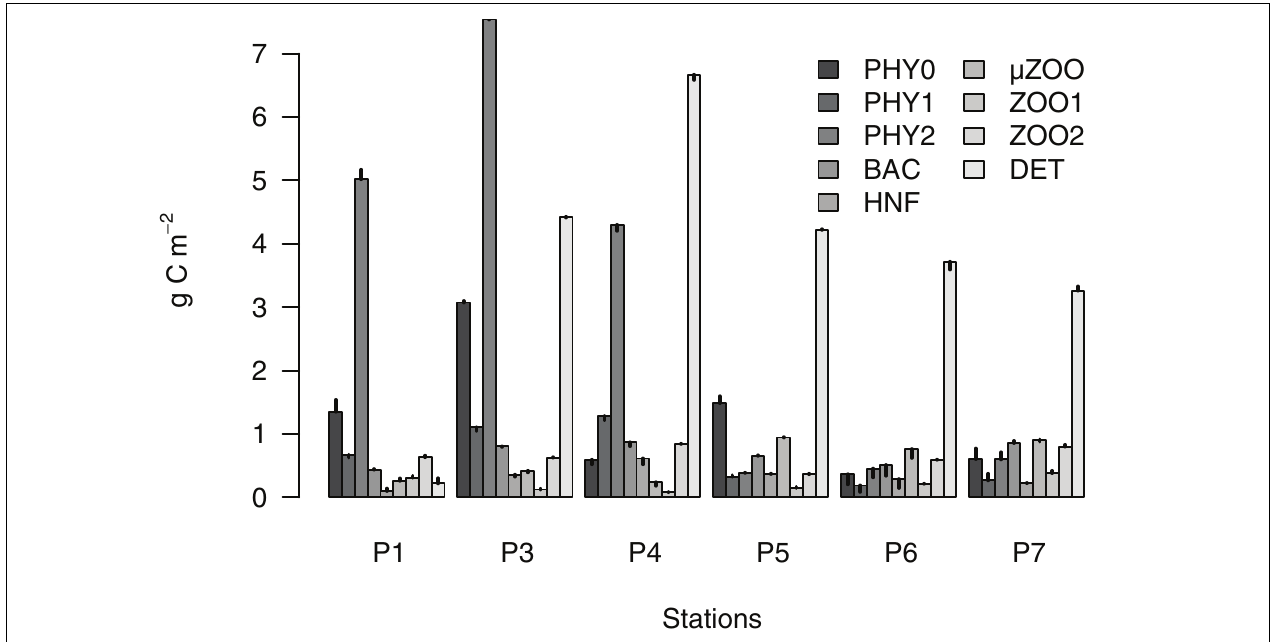
FIGURE 3 | Biomass of the measured particulate food web compartments in the upper 40 m water column of stations P1–P7. The error bars show the daily rate of change of the biomass (g C m − 2 d − 1 ), as estimated by the inverse solution.